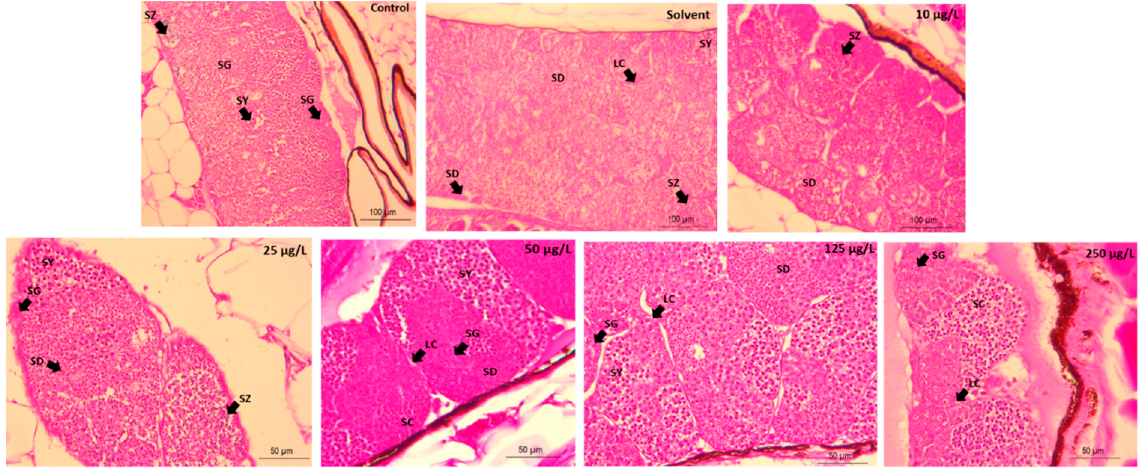
Figure 2. Microphotograph (H&E stain, mag. ×40) of Javanese medaka testes at 21 days post-exposure to sublethal concentration of 3,4-DCA. SC, Sertoli cell; LC, Leydig cell; IPF, intravascular proteinaceous fluid, spermatogonia; SG, spermatocytes; SY, spermatids; SD, spermatozoa; SZ.